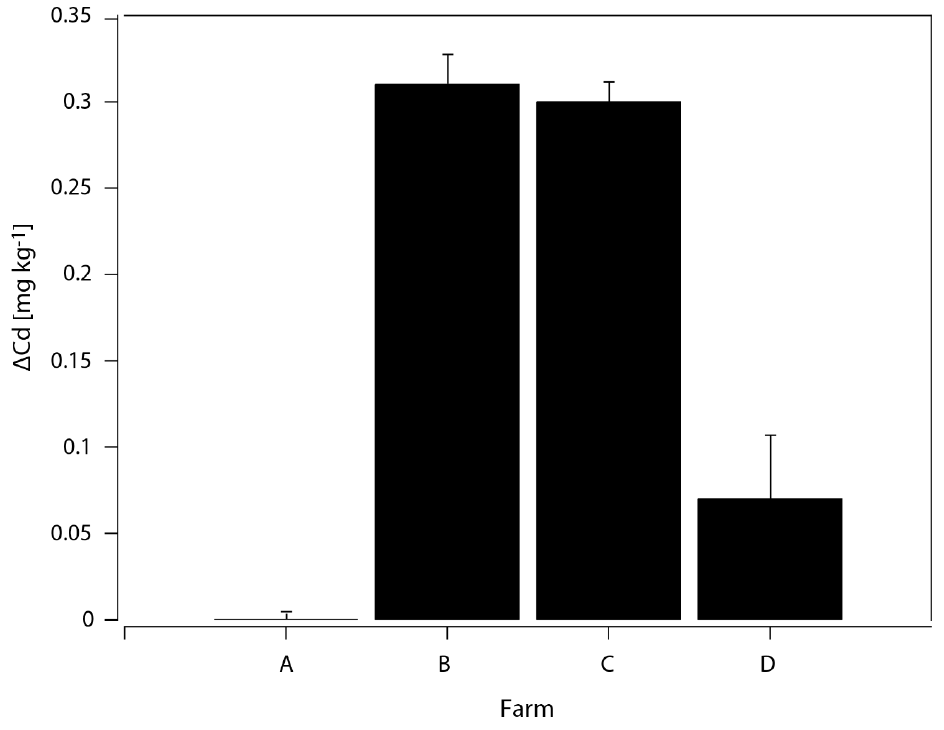
Figure 4. Variation of Cd content in soil ( Δ Cd) observed in the 4 farms assessed 1 year after applying the treatments. Cadmium content in soil by the closed digestion method by Inductively Coupled Plasma Optical Emission Spectrometer (ICP-OES) [21]. Farm A showed a minimal variation in Cd soil content (less than 0.004 mg kg −1 Cd).